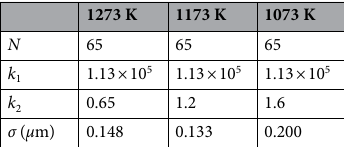
Table 4. Model parameters obtained from curve